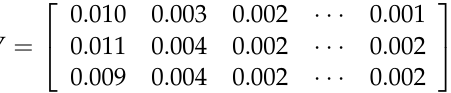
Table 6. Comprehensive benefit evaluation results. IEGES Eigenvalues Benefit Level Sort S